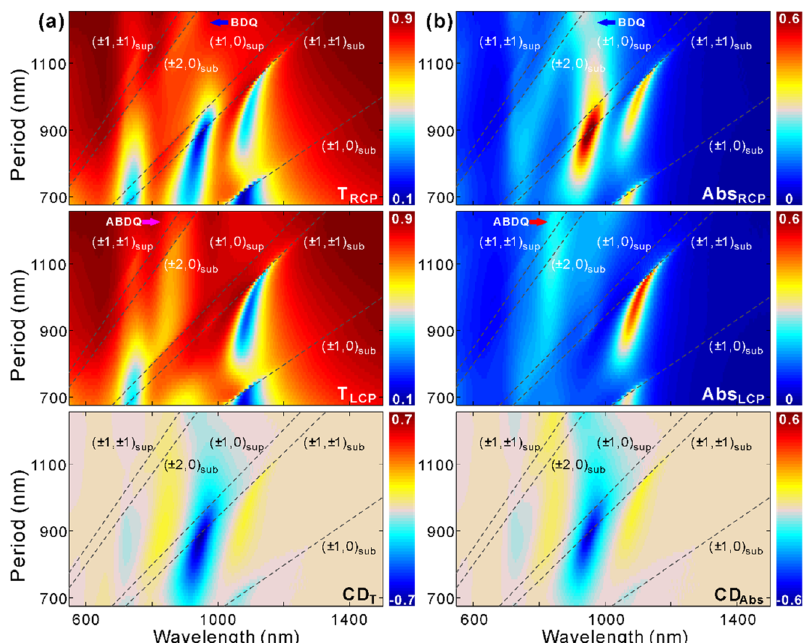
Figure 6: (a) Transmission under RCP (upper panel) and LCP (middle panel) incidences, as well as CD spectra (lower panel) for the stereo-SRR dimer arrays with different periods.(b)ThecorrespondingRCPandLCP incidences absorption (upper and middle panels), as well as CD in absorption (lower panel)spectra.The unithasbeenconverted into absorption cross section ( μ m 2 ) by multiplying the area of the unit cell. The dashedlinesindicateRAs,andthe blueand red arrows in Figure 6b denote the BDQ and ABDQ resonances,